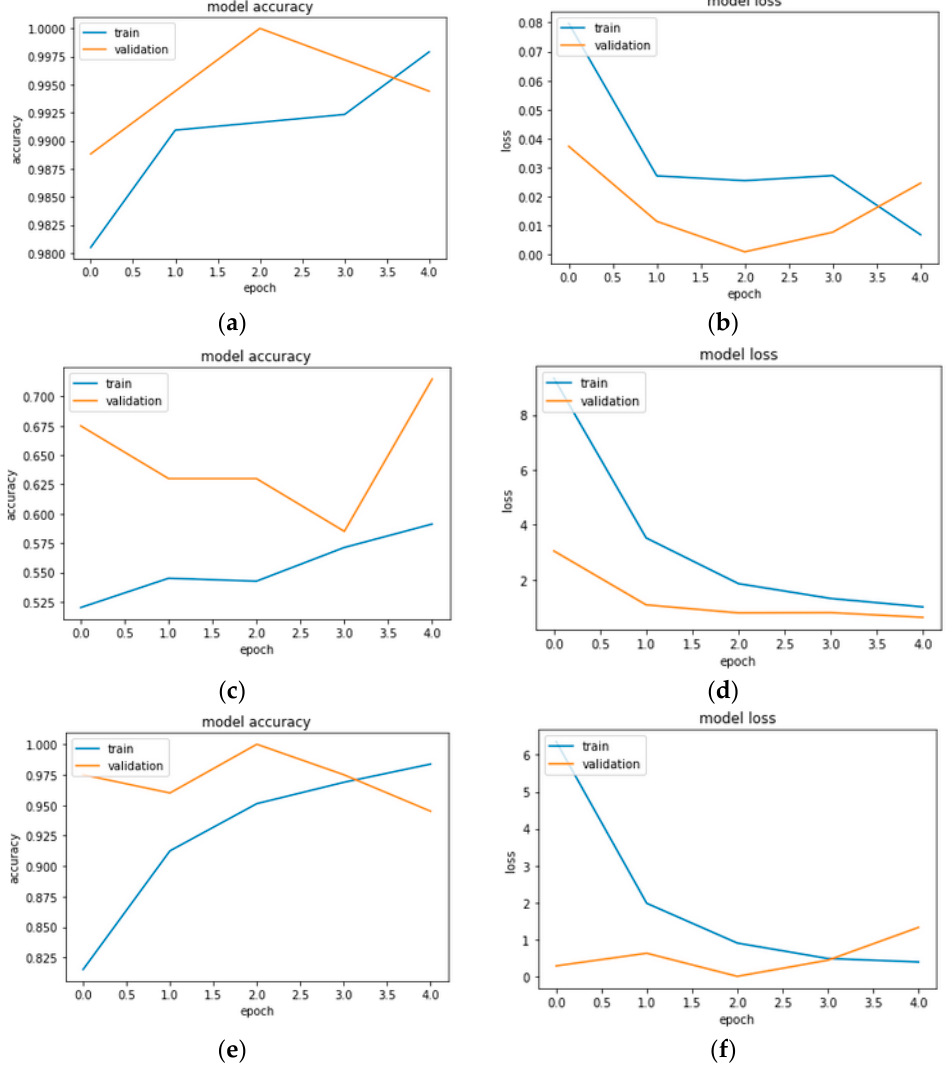
Figure 8. Validation and training analyses over five epochs of the pre-trained Inception model, using various datasets: ( a ) validation and training model accuracy analysis, using the Clarkson 2015 dataset; ( b ) validation and training model loss analysis, using the Clarkson 2015 dataset; ( c ) validation and training model accuracy analysis, using the IIITD dataset; ( d ) validation and training model loss analysis, using the IIITD dataset; ( e ) validation and training model accuracy analysis, using the ND_Iris3D_2020 dataset; and ( f ) validation and training model loss analysis, using the ND_Iris3D_2020 dataset.